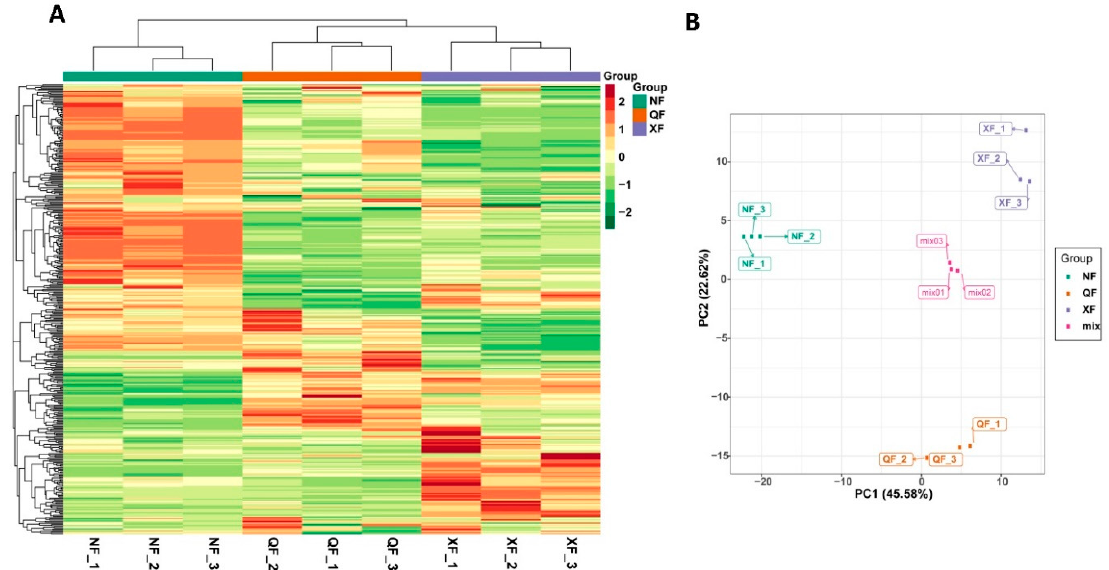
Figure 2. Overview of global metabolic profiles in wolfberry fruits collected from three planting areas. ( A ) Heatmap hierarchical clustering and ( B ) principal component (PC) analysis. NF, XF and QF represent Ningxia, Xinjiang and Qinghai planting areas, respectively. Mix represents the mixed samples used for quality control. Data shown are the log 2 fold change of the metabolite ion intensity.